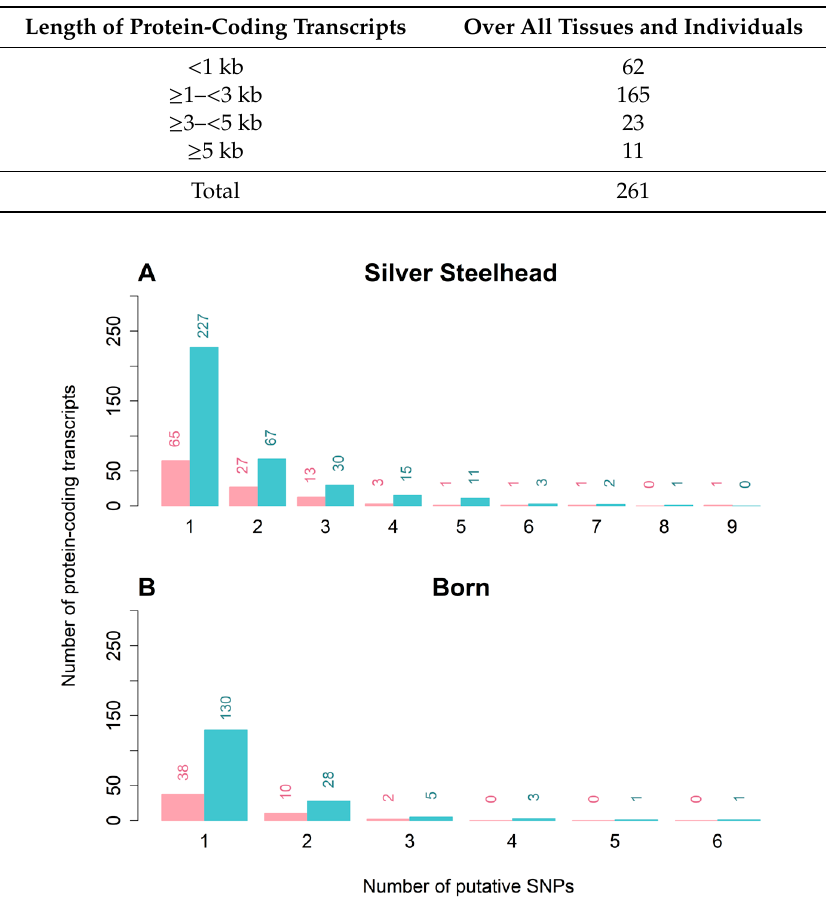
Table 3. Number of putative SNPs (exonic-gene symbol) over all tissues and individuals by length of protein-coding transcripts.